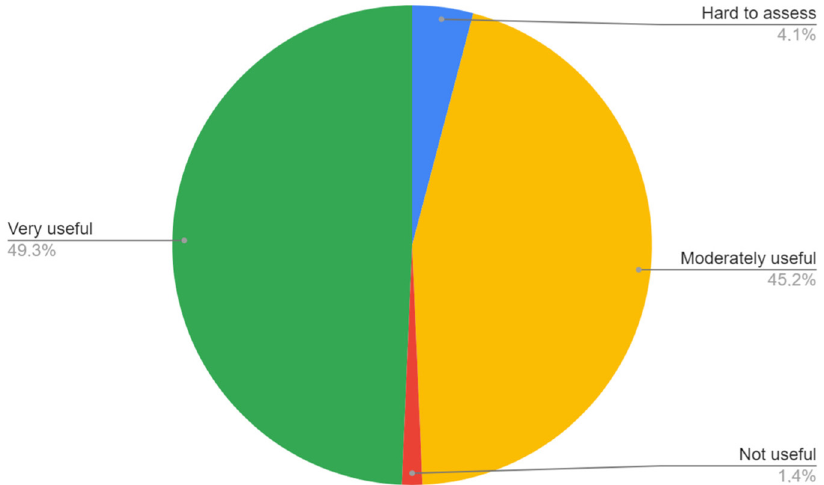
Figure 2. Respondents’ opinion on utility of ABI in diagnosis of